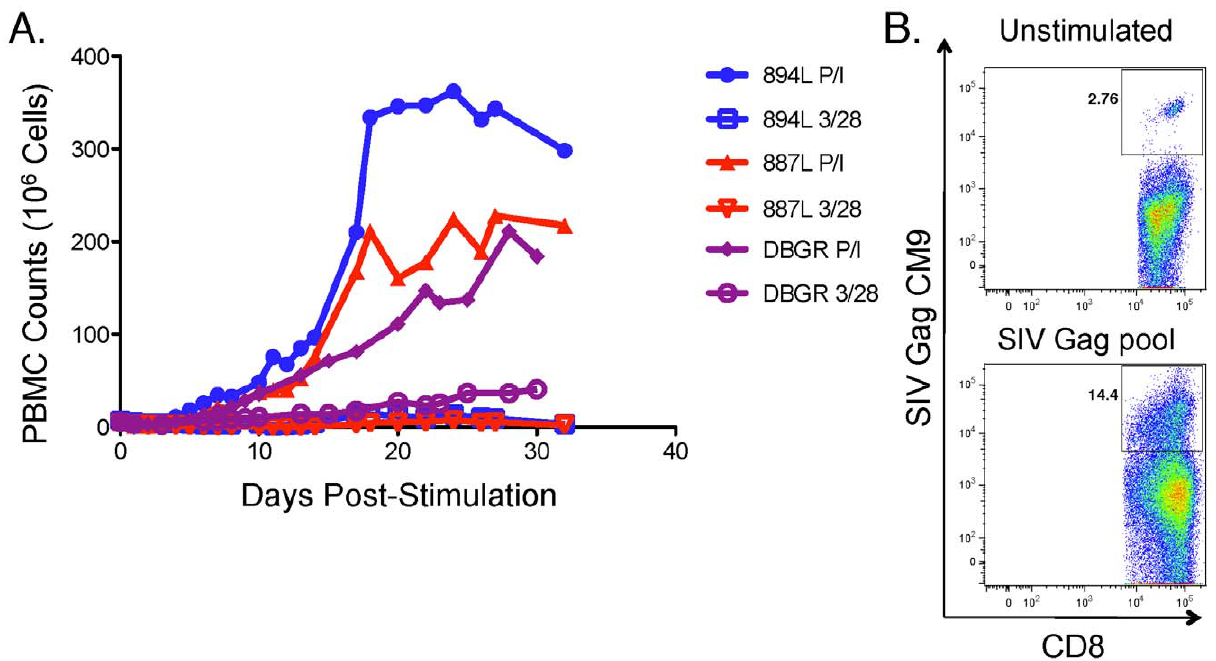
Figure 5. PBMC from progressors can be expanded invitro after treatment with phorbol esther and calcium ionophore. A. Three Mamu A*01 + rhesus macaques (894L, 887L, DBGR) were stimulated for 6 hours with phorbol-12-myristate-13-acetate (PMA, 400 ng/ml) and ionomycin (Io, 2 m M) on day 0, washed, re-suspended in medium containing 40 IU/mL of IL-2 and cultured for at least 30 days. Top medium was replaced with fresh IL-2-containing medium and counted every 24–48 hours. The controls were not treated with PMA/Io on day 0 but were stimulated with anti-CD3 and anti-CD28 monoclonal antibodies during the first 6 days. B. PBMC from another Mamu A*01 + rhesus macaque were stimulated with the same concentrations of PMA/Io for 6 hours on day 0 and propagated in culture for an additional 18 days as described above. A pool containing 15-mers spanning the entire SIV Gag sequence was used to stimulate half of the cells on day 18. PBMC were stained on day 24 with the Mamu A01-restricted CTPYDINQM (CM9) tetramer to measure SIV-specific expansion.